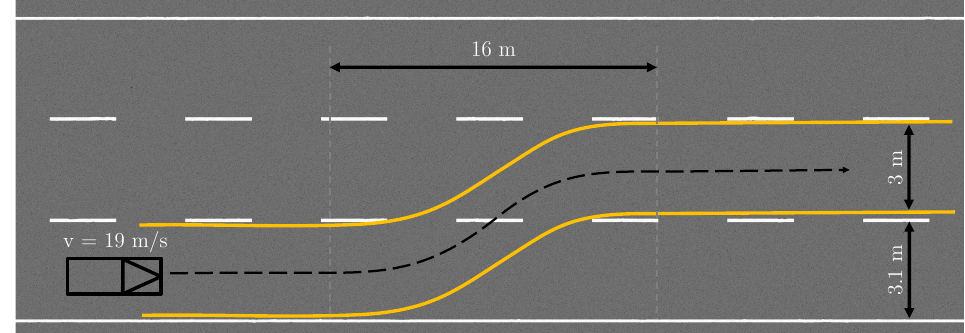
Figure 14. Overview of the construction scenario due to the ODD extension.